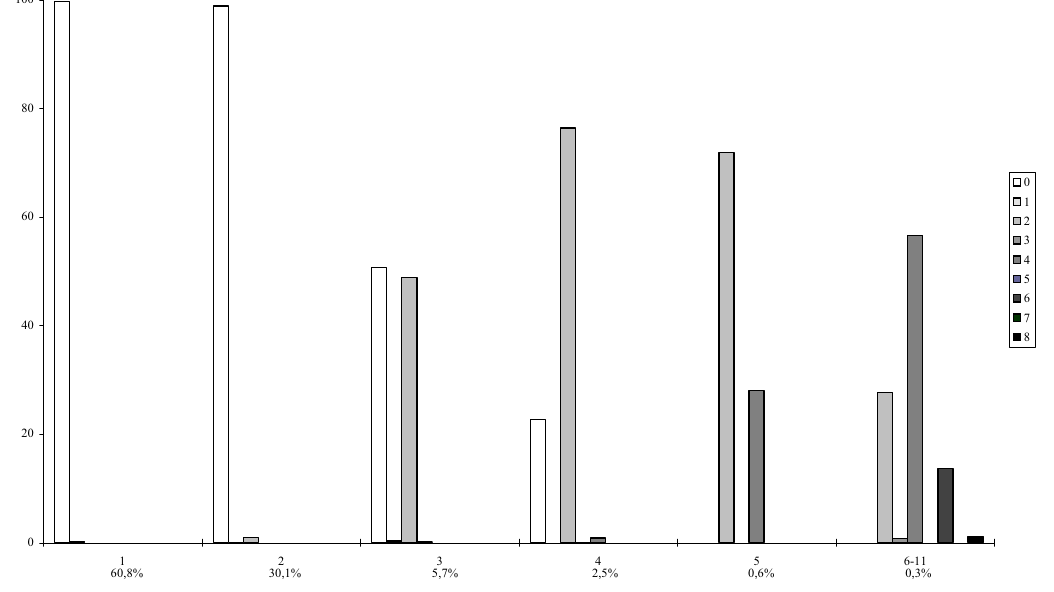
Figura 5 – Frazione di transizioni del data set INPS non rilevate dal piano di osservazione ‘abbina- mento a tre occasioni’, per numero di transizioni per lavoratore (anno 1995; popolazione standar- dizzata; totale lavoratori con transizioni: